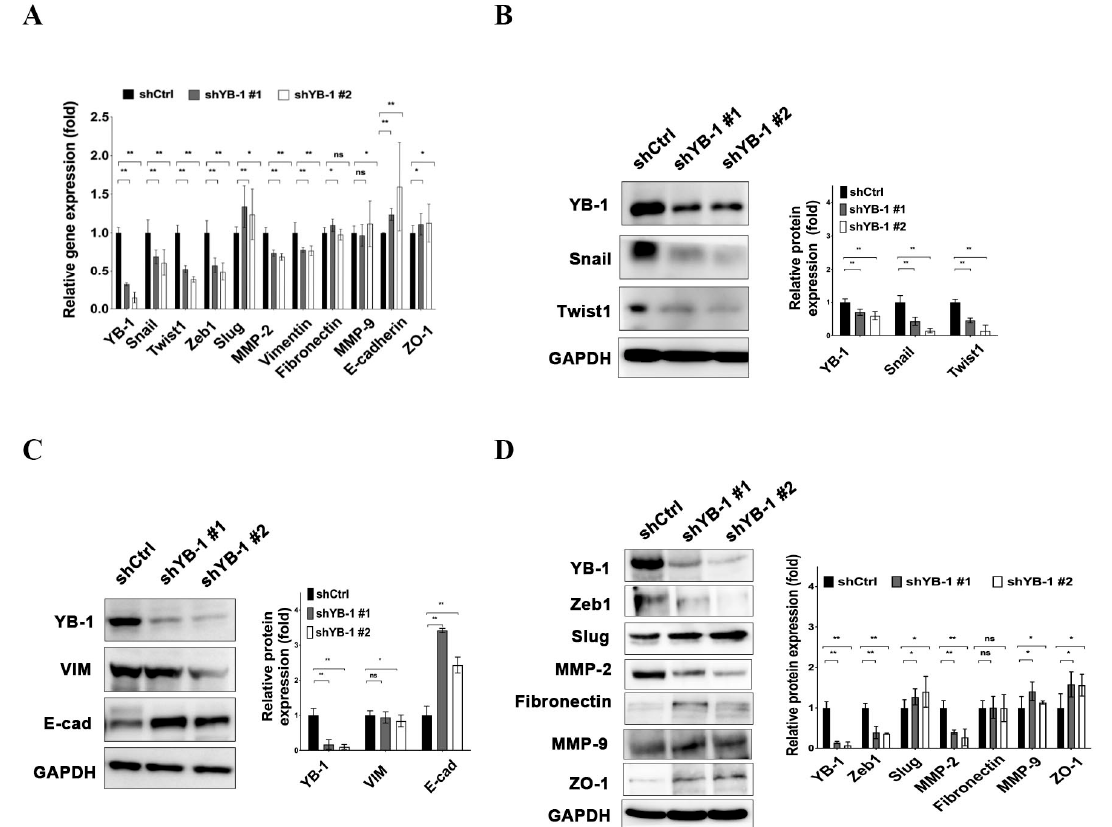
Figure 5. YB-1 enhances epithelial-mesenchymal transition (EMT)-associated gene and protein expression in HuH-7 R cells. ( A ) mRNA levels of EMT-associated genes were assessed via quantitative real-time PCR (qPCR) after YB-1 silencing in HuH-7 R cells. ( B – D ) Protein expression levels of EMT-associated genes after YB-1 knockdown in HuH-7 R cells detected by immunoblotting with the indicated antibodies using GAPDH as the loading control. Quantified data are presented as means ± SD. All results are representative of at least three independent biological replicates. shCtrl, control shRNA; shYB-1, shRNA against Y-box binding protein-1. p Values were determined using the t test (ns, not significant; * p < 0.05; ** p < 0.01).